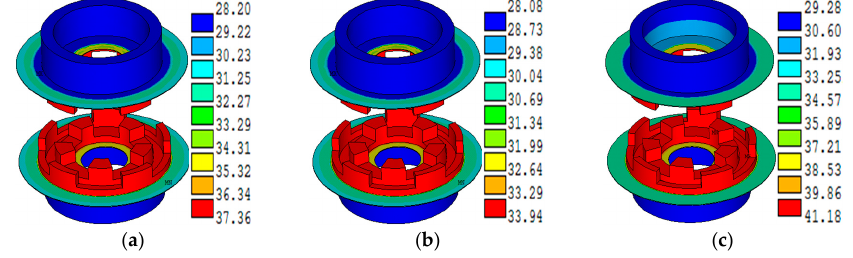
Figure 22. Temperature distribution of the axial field structure under different AMMF (°C); ( a ) 0 At AMMF; ( b ) 600 At AMMF; and, ( c ) 900 At AMMF.